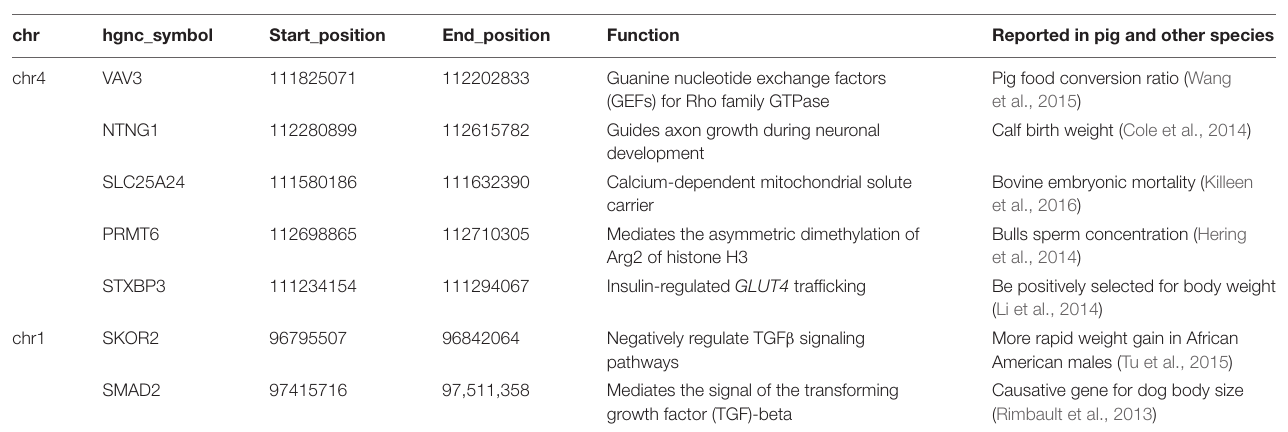
FIGURE 4 | Fine-mapping in the chromosome 4: 111,031,589–113,031,589 region. (A) Individual SNP association study and its locuszoom plot. (B) The posterior probability of clusters. (C) The posterior probability of SNPs. TABLE 2 | Candidate genes for birth weight located around the causal